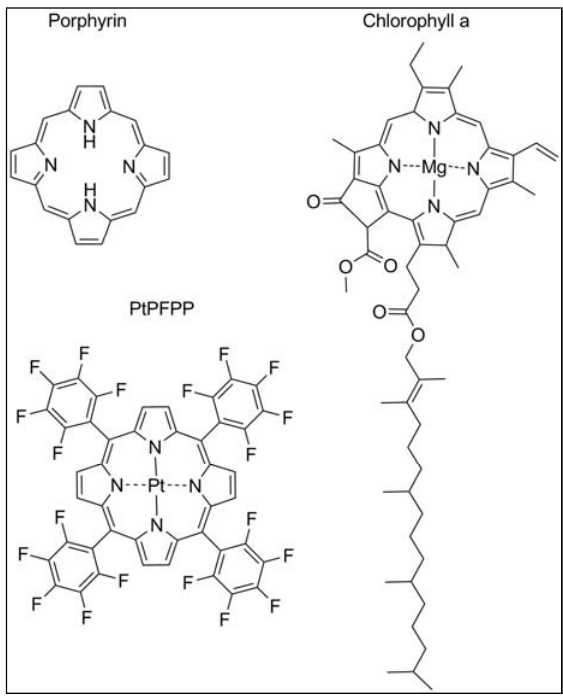
Figure 2. Structural similarities of porphyrin, chlorophyll a and the oxygen probe